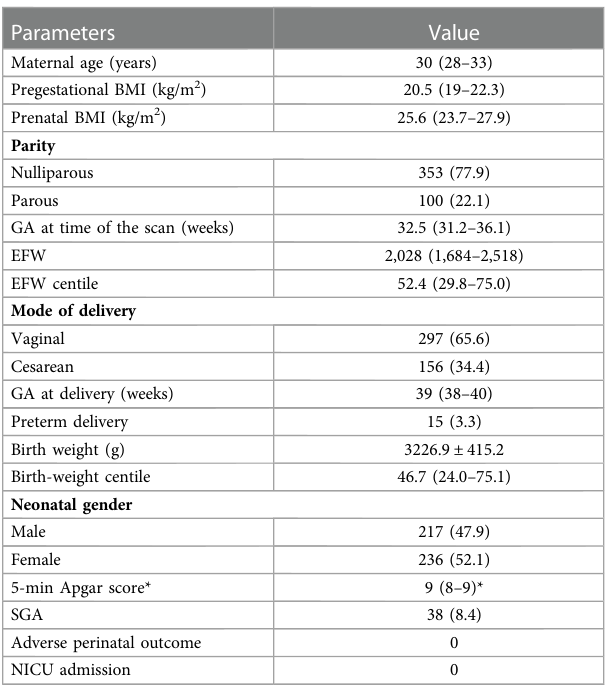
The left and right ventricular ESA and EDA increased with advancing gestational age (left: R = 0.412 – 0.504, P < 0.001; right: